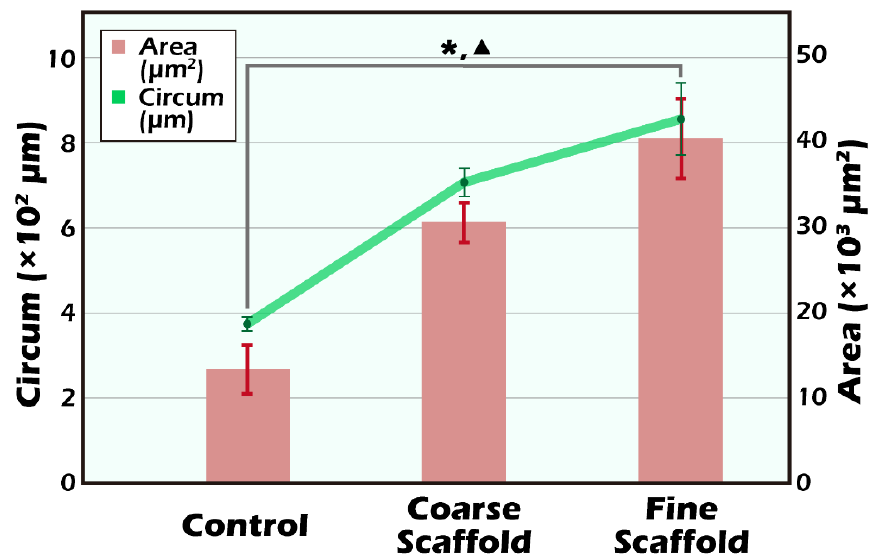
Figure 5. The measurement of the circumference and area of seminiferous tubules was randomly applied to three seminiferous tubules (mean +/SD) and displayed a significantly larger area in the fine scaffolds in comparison to the control group (* p < 0.05). With regard to the circumference of seminiferous tubules, the fine scaffolds also showed better results as opposed to the control group ( (cid:78) p < 0.05). There was no significant difference between the coarse scaffold and fine scaffold, or the coarse scaffold and control